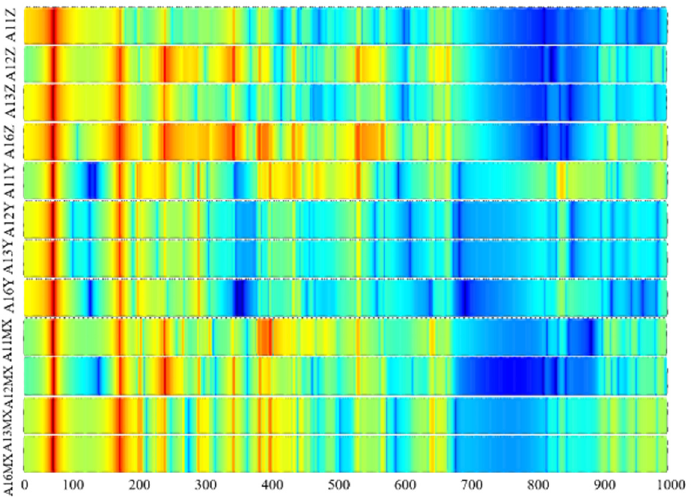
Figure 14. Vibration power flow transfer path analysis of P8.